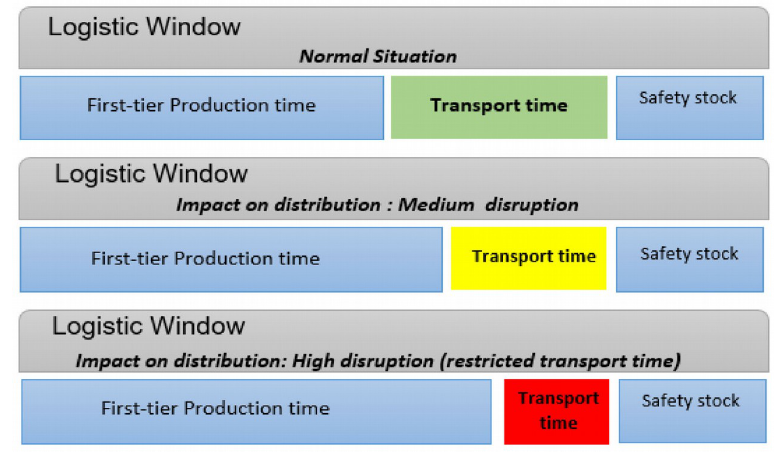
Figure 2. Mass customization logistic